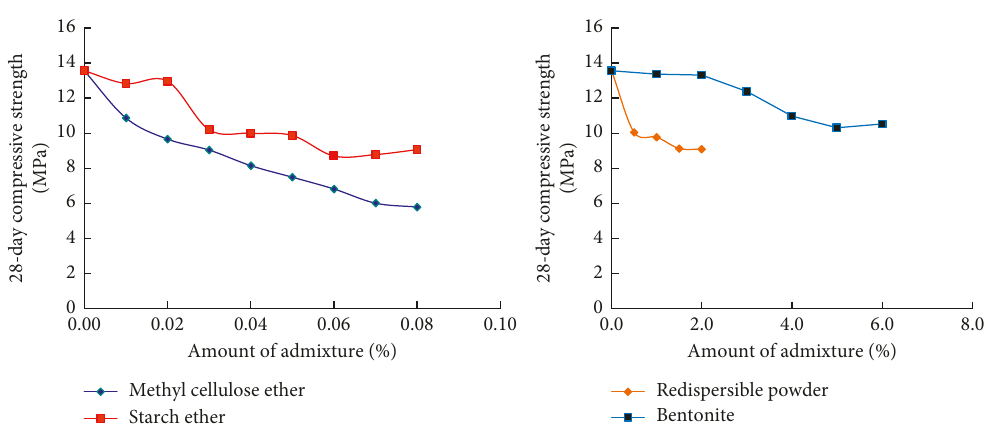
Figure 9: Relationship between the 28-day compressive strength of mortar and amount of admixture.